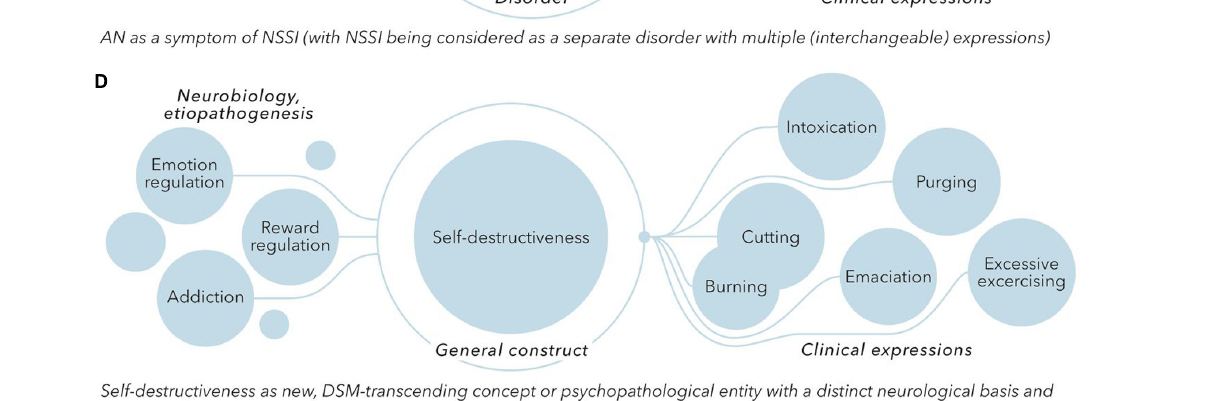
FIGURE 2 | (A) NSSI and AN as two separate disorders, with some degree of overlap in neurobiology and psychology, leading to comorbidity. (B) NSSI as a symptom of AN [like it can be a symptom of boulimia nervosa (BN) or borderline personality disorder (BPD)]. (C) AN as a symptom of NSSI (with NSSI being considered as a separate disorder with multiple (interchangeable) expressions). (D) Self-destructiveness as new, DSM-transcending concept or psychopathological entity with a distinct neurological basis and a variety of clinical expressions.